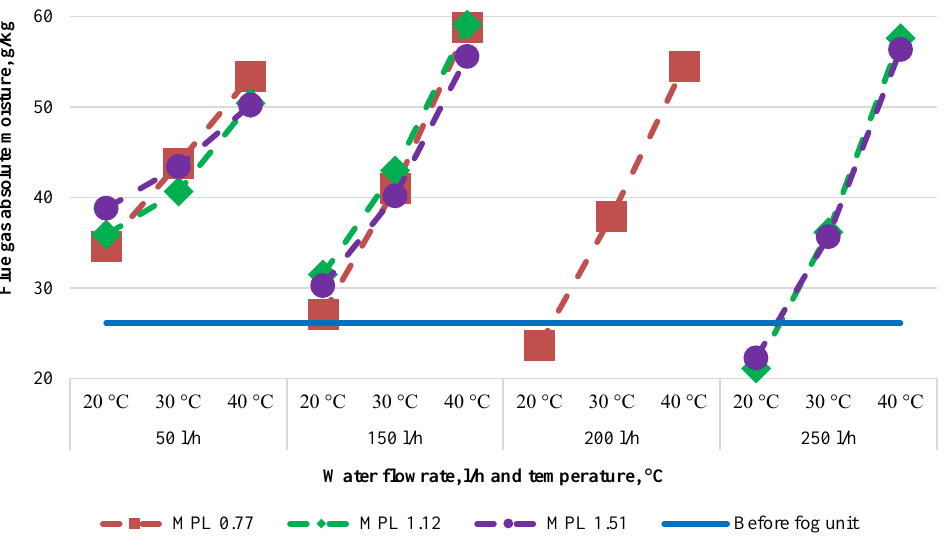
Fig. 2. Effects of nozzle size, sprayed water amount and temperature on absolute moisture content after the fog unit. Effects of nozzle on the absolute moisture content of flue gas is not as strong as it was found for flue gas temperature. The difference of absolute moisture content of flue gas between used nozzles varies by just 1–3 g/kg at high water flowrate. However absolute moisture content of flue gas between used nozzles can vary by 10 g/kg at low water flowrate 50